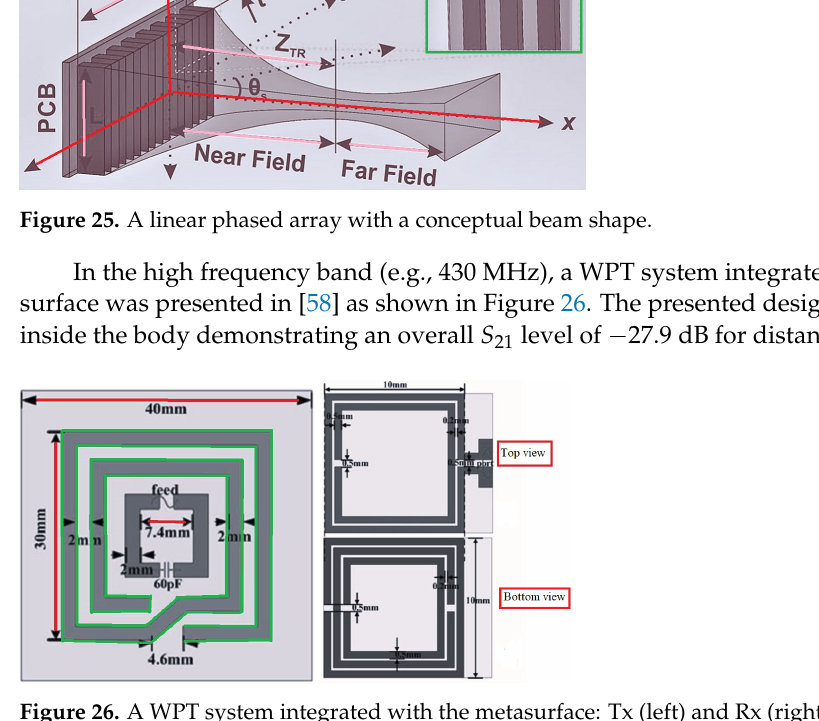
Figure 26. A WPT system integrated with the metasurface: Tx (left) and Rx (right)